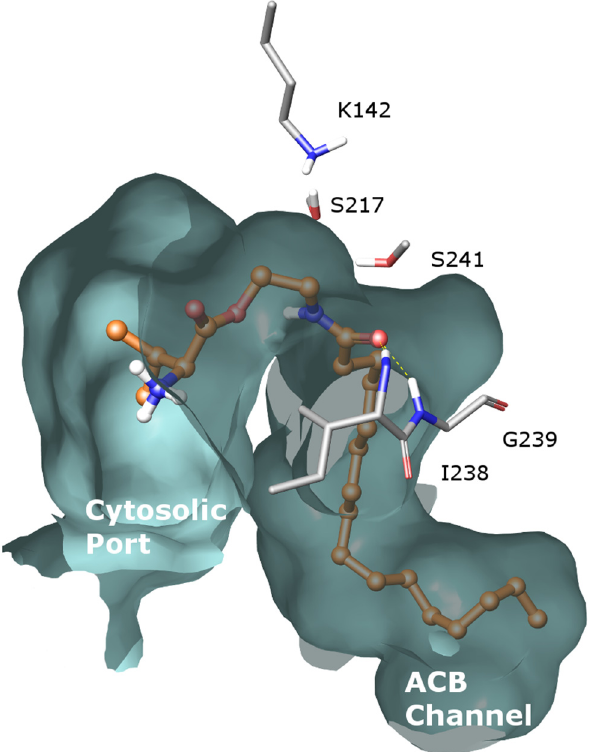
Fig 9. Docking of L-Val-PEA (20) into rat FAAH active site. Representation of L-Val-PEA ( 20 ) docked into rat FAAH active site. The amide group undertakes hydrogen bonds with the two NH groups of I238 and G239 belonging to the oxyanion hole and with the backbone carbonyl of M191 (not shown). The catalytic triad S217, S241 and K142 is also displayed. The palmitoyl portion fits the acyl chain binding (ACB) channel and the valine occupies the cytosolic